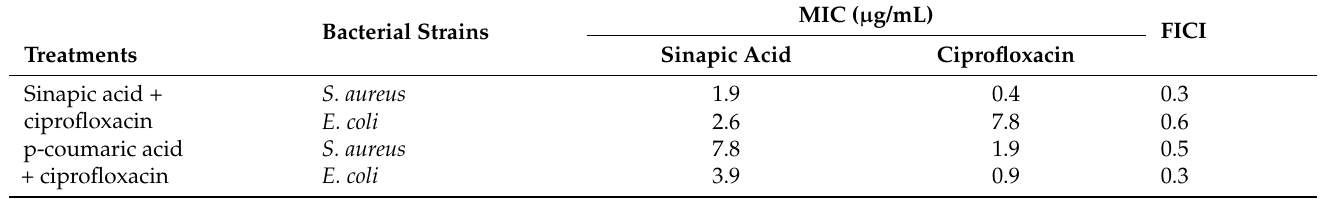
Figure 7. Time-kill kinetics of ( a ) sinapic acid and Staphylococcus aureus , ( b ) p-coumaric acid and S. aureus , ( c ) ciprofloxacin and S. aureus , ( d ) sinapic acid and Escherichia coli , ( e ) p-coumaric acid and E. coli , ( f ) ciprofloxacin and E. coli. Table 5. The minimum inhibitory concentration and fractional inhibitory concentration index (FICI) of the phenolic acid/antibiotic combination against the bacterial strains. MIC ( µ Bacterial Strains